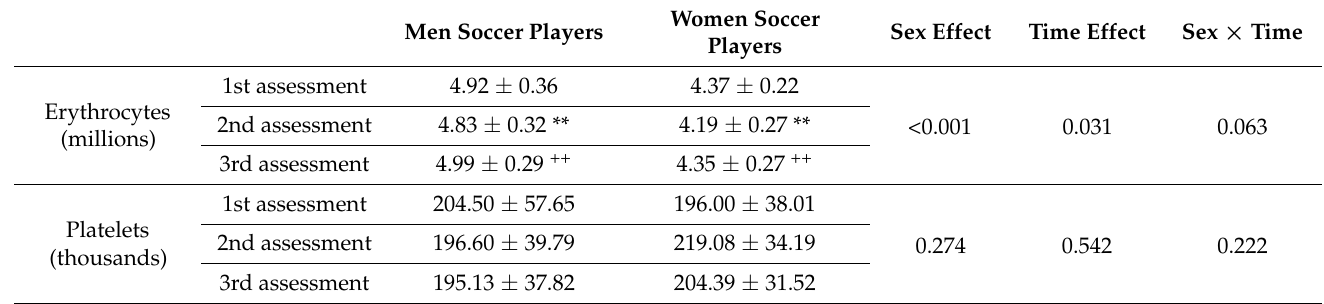
Table 7. Erythrocyte and platelet values according to sex throughout the